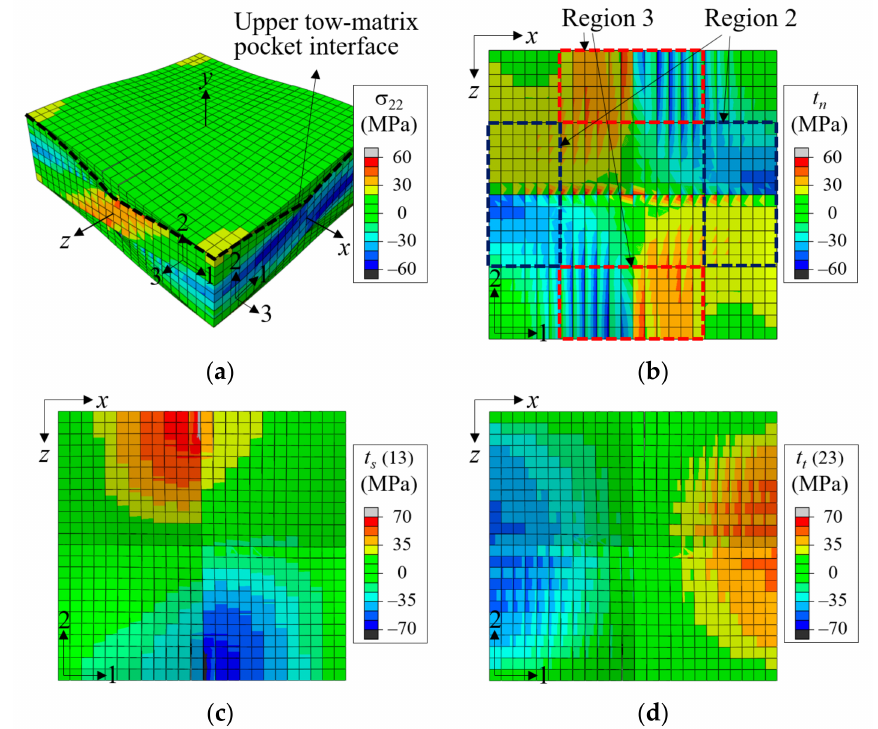
Figure 21. Distribution of σ 22 of bulk elements and tractions of cohesive elements at the upper tow-matrix pocket interface for in-phase plain weave unit cell without defect at ˆ ε xx = 0.0073: ( a ) σ 22 ; ( b ) normal traction ( t n ); ( c ) 13-shear traction ( t s ); and ( d ) 23-shear traction ( t t ), (deformation scale factor = 5).